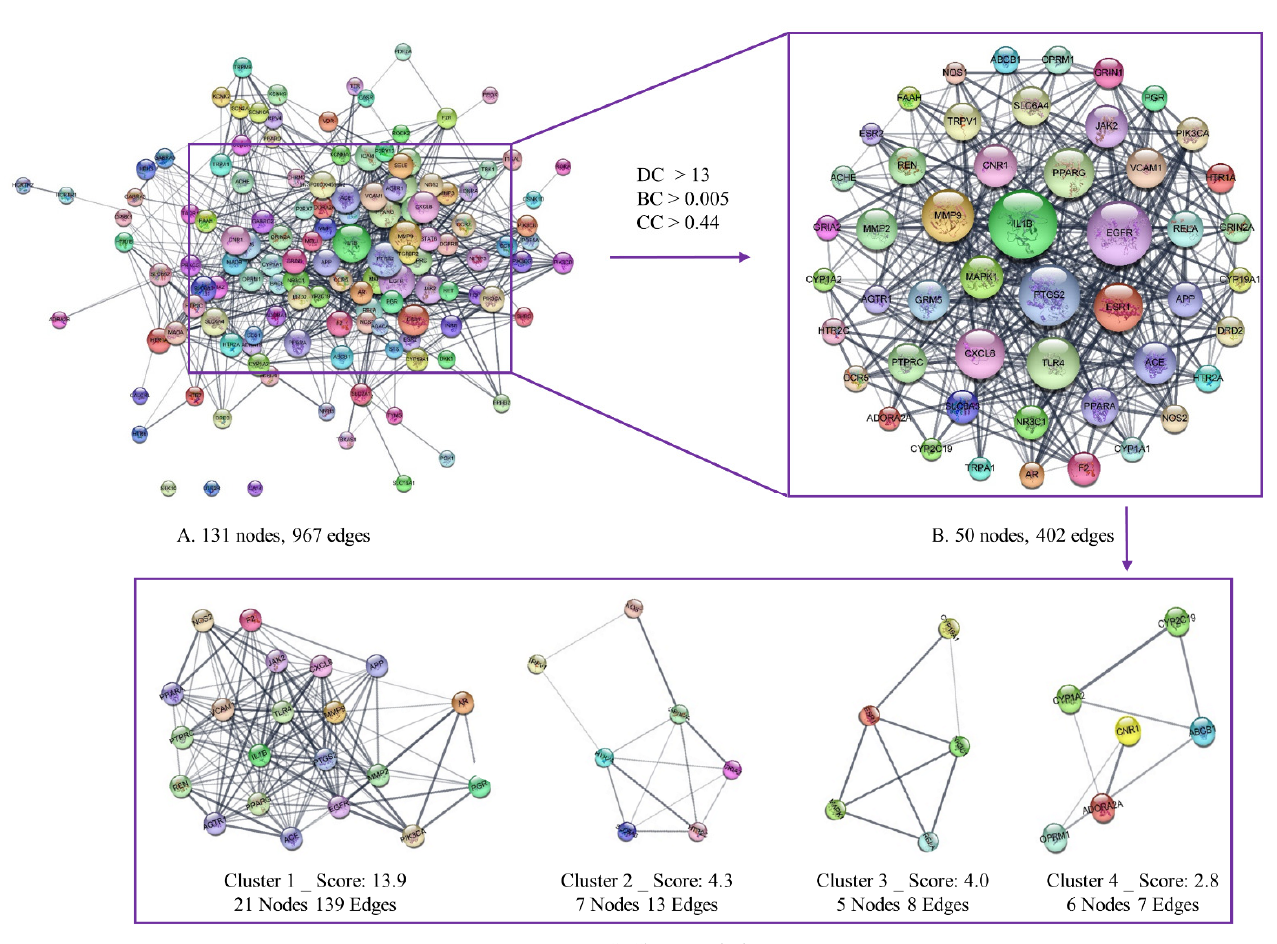
Figure 3. Identification of potential therapeutic targets for ALHP against migraines. ( A ) Construction of PPI networks of overlapping genes between ALHP and migraines via STRING. ( B ) Significant module determined via the function of topology analysis in Cytoscape. ( C ) Four clusters were predicted and visualized via the cluster analysis with MCODE algorithm (K-core threshold = 2). BC, betweenness centrality; CC, closeness centrality; DC, degree